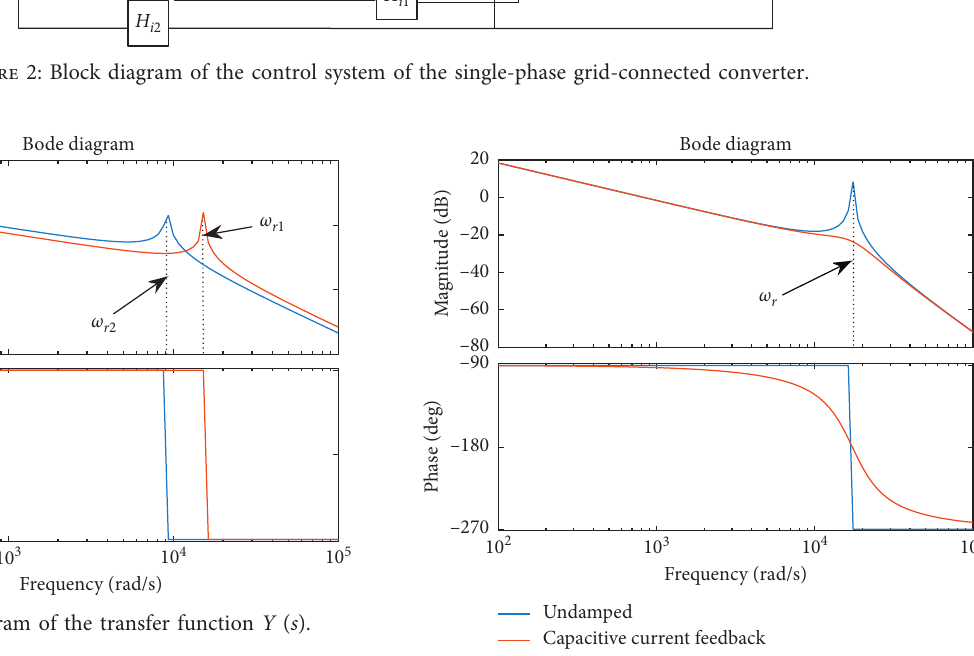
Figure 4: Capacitive current feedback damping.